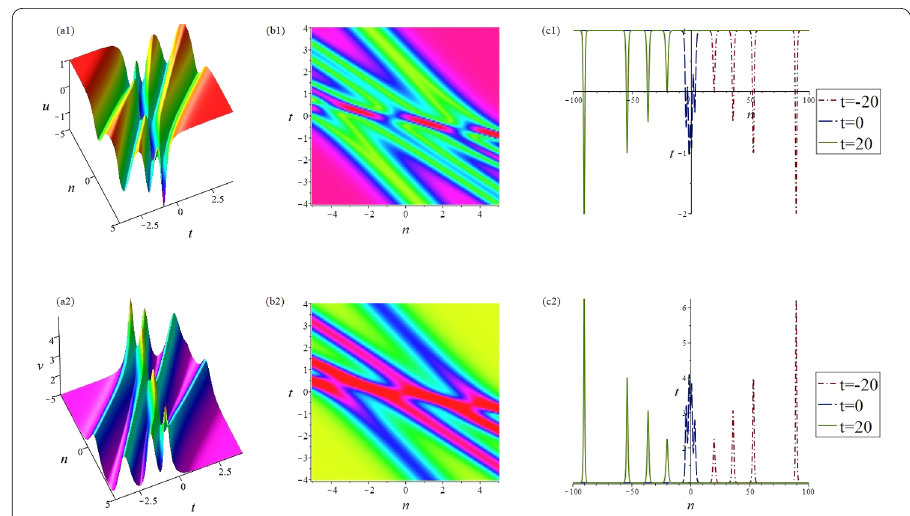
Figure 3 ( a1 ), ( b1 ) Overtaking elastic interactions of dark four-soliton solution (cid:8) u n in (45) with the parameters r 1 = 1, r 2 = –1, r 3 = 1 , r 2 = – 1 , λ 1 = –4, λ 2 = –3, λ 3 = –2.5, λ 4 = –2. ( a2 ), ( b2 ) Overtaking elastic interactions of 2 2 bright four-soliton solution (cid:8) v n in (45) with the same parameters as in (a1), (b1). The interaction processes for ( c1 ) (cid:8) u n and ( c2 ) (cid:8) v n at t = –20 (dash-dot line), t = 0 (dashed line), and t = 20 (solid line)